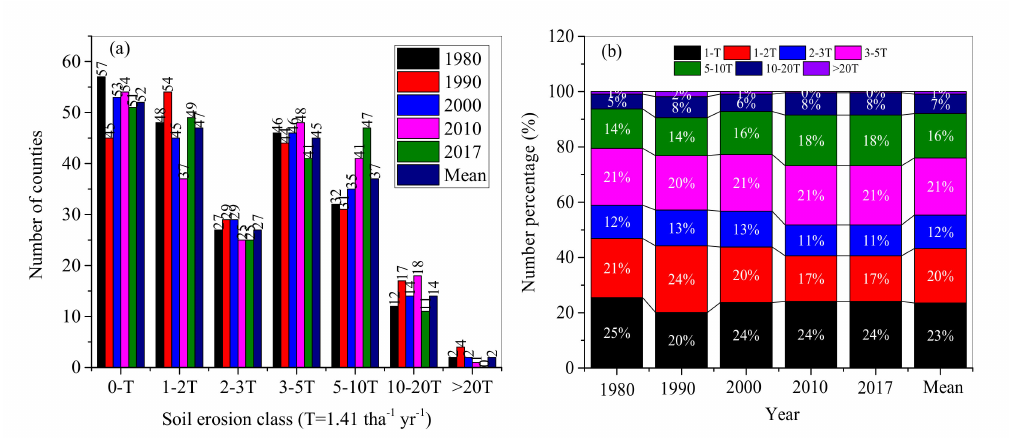
Figure 9. Changes of the number of counties ( a ) and the number percentages ( b ) with di ff erent soil erosion grades during